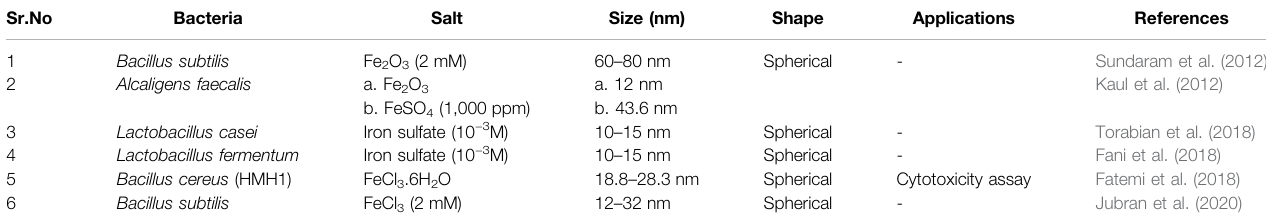
TABLE 3 | Biosynthesis of Iron oxide nanoparticles by using bacteria.